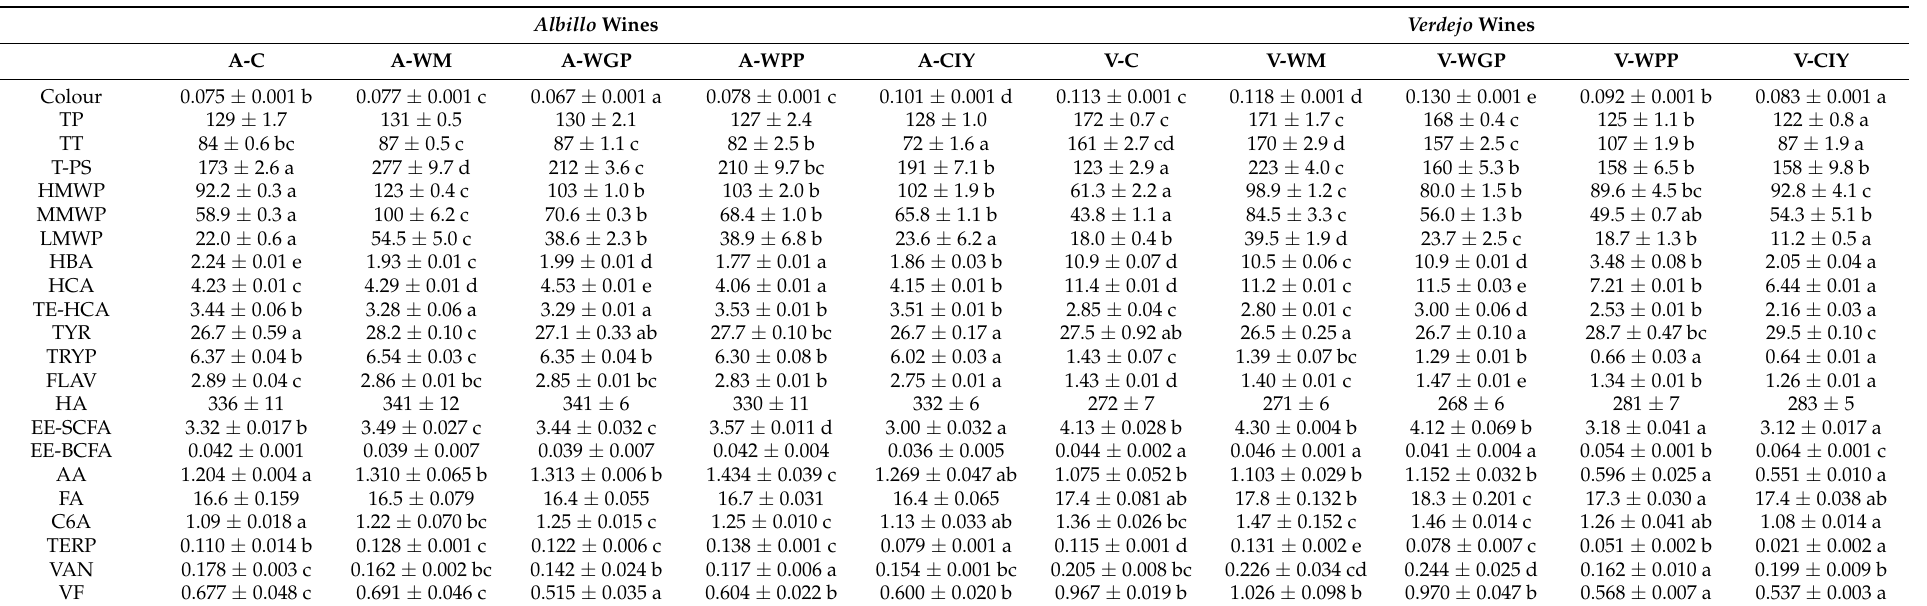
Table 3. Parameters and compounds (in mg/L) analyzed of the Albillo and Verdejo wines 1 . Albillo